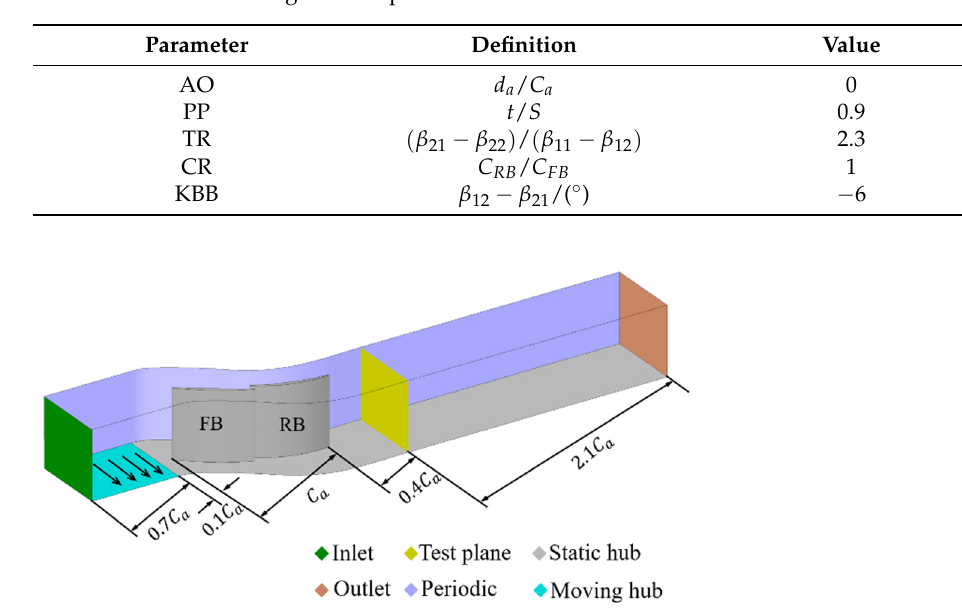
Figure 1. Two-dimensional blade profile and three-dimensional straight blade of the original cascade and the tandem cascade. Table 2. Tandem cascade geometric parameters.